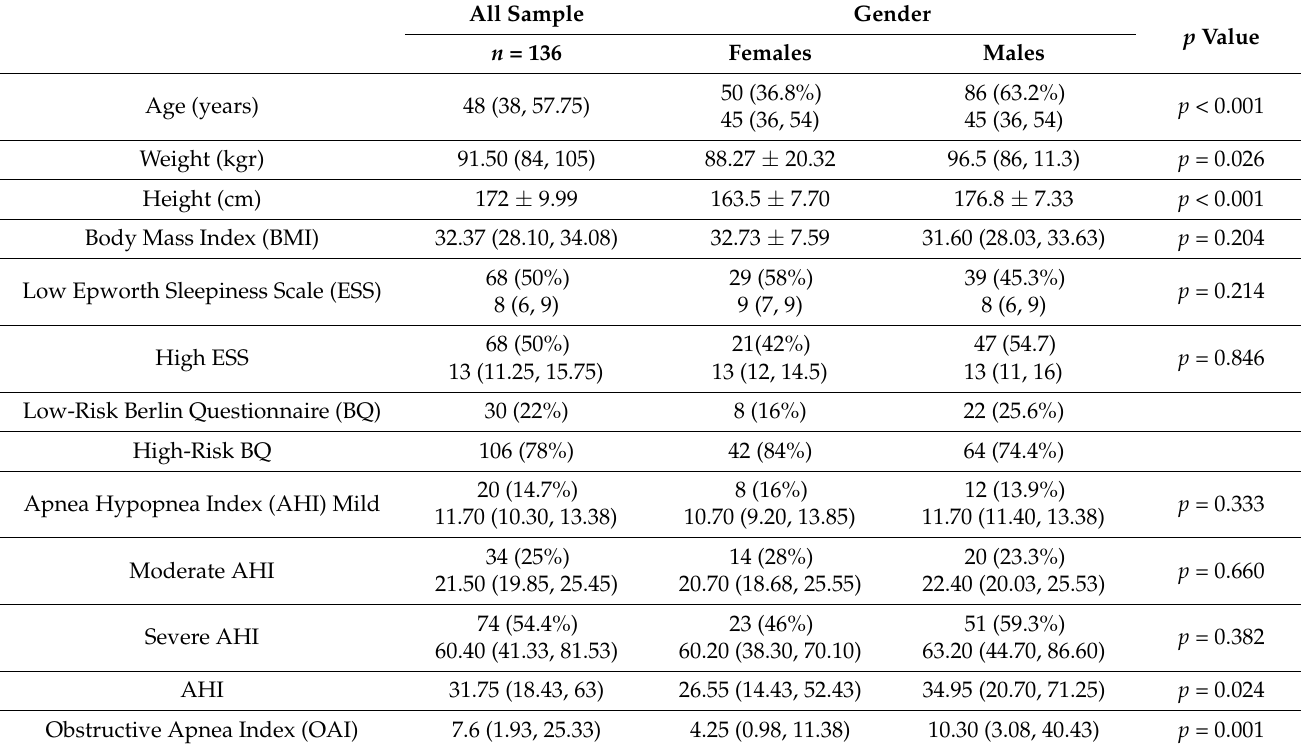
Table 1. Sample demographics, questionnaires, and PSG results. All Sample